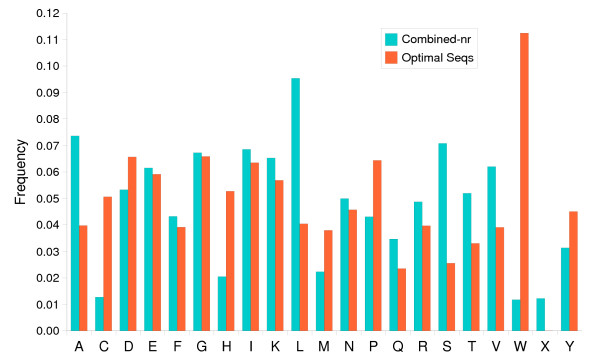
Amino acid residue make-up of the optimal sequences.  Bars in turqoise represent the proportion of each amino acid residue in the Combined-nr database from which the PSI-BLAST profiles were built. Bars in orange also show the proportion of each amino acid, this time from the optimal sequences generated from the same profiles.